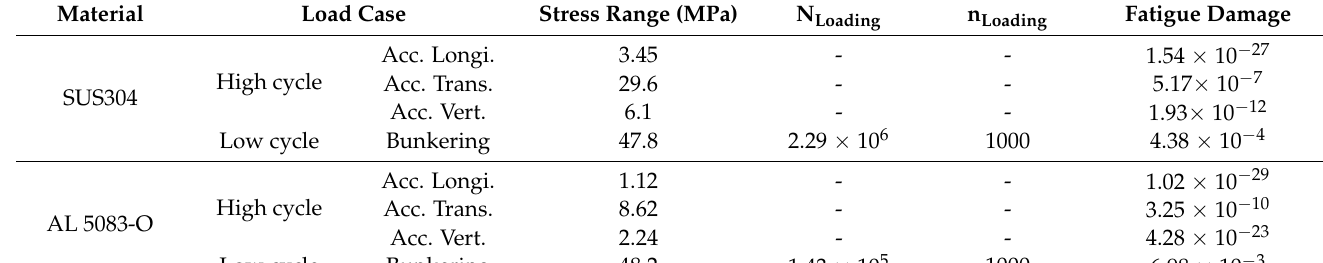
Table 8. Summary of fatigue analysis results.